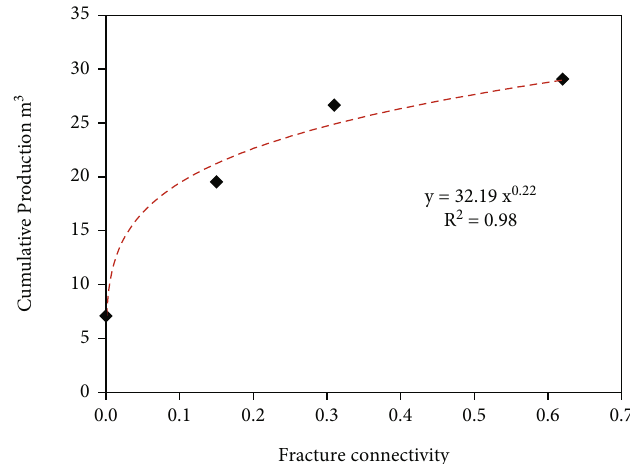
Figure 9: Relation equation between fracture connectivity and 200-day cumulative